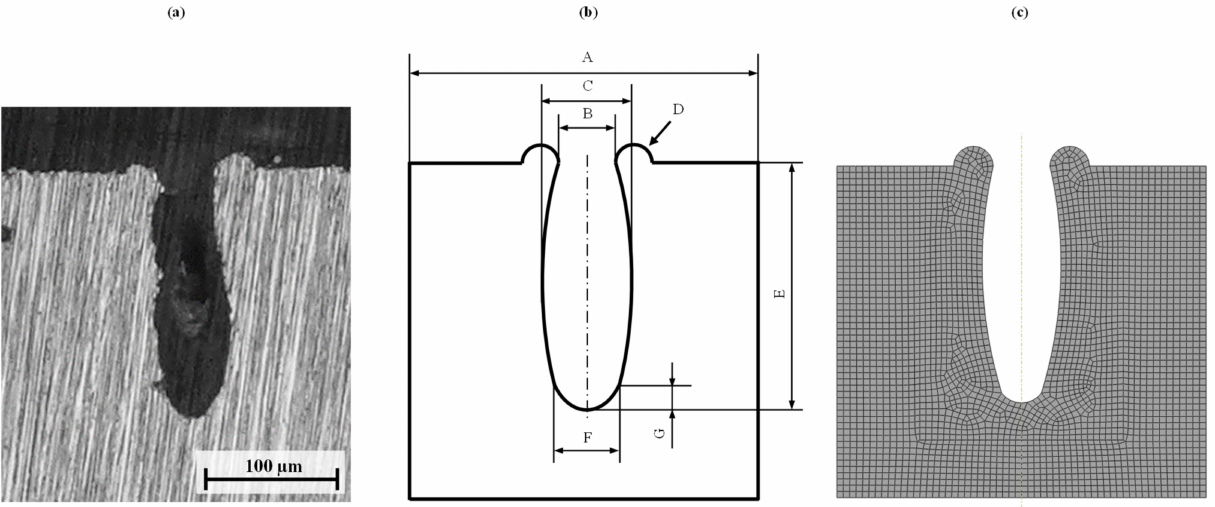
Figure 2. Microsection ( a ); parametrization rule ( b ); and FE model ( c ).